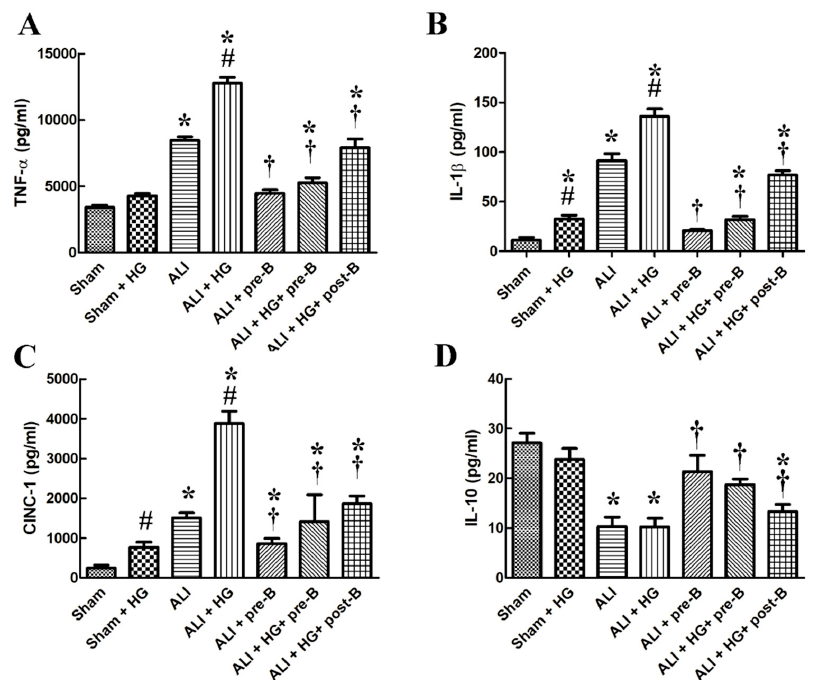
Figure 4. Effects of hyperglycemia and NKCC1 inhibitor treatment on the levels of cytokines. Higher levels of serum TNF- α ( A ), IL-1 β ( B ), CINC-1, ( C ) and lower level of IL-10 ( D ) were observed in rats from the ALI and ALI + HG groups ( p < 0.05). However, the higher levels of pro-inflammatory cytokines and lower level of anti-inflammatory cytokine was noted in the ALI + HG group than in the ALI group ( p < 0.05). The NKCC1 inhibitor reduced the levels of these pro-inflammatory cytokines and increased the levels of anti-inflammatory cytokine in rats from both ALI and ALI + HG groups ( p < 0.05). *Significant difference, as compared to the sham group ( p < 0.05), # Significant difference, comparing the groups with HG to those without HG (I vs. II, III vs. IV, V vs. VI, and V vs. VII, p < 0.05), † Significant difference, comparing the ALI groups with B to those without B (III vs. V, IV vs. VI, and IV vs. VII, p < 0.05). Abbreviation: TNF- α = tumor necrosis factor alpha, IL-1 β = interleukin 1 beta, CINC-1 = cytokine-induced neutrophil chemoattractant 1, IL-10 = interleukin 10, ALI = acute lung